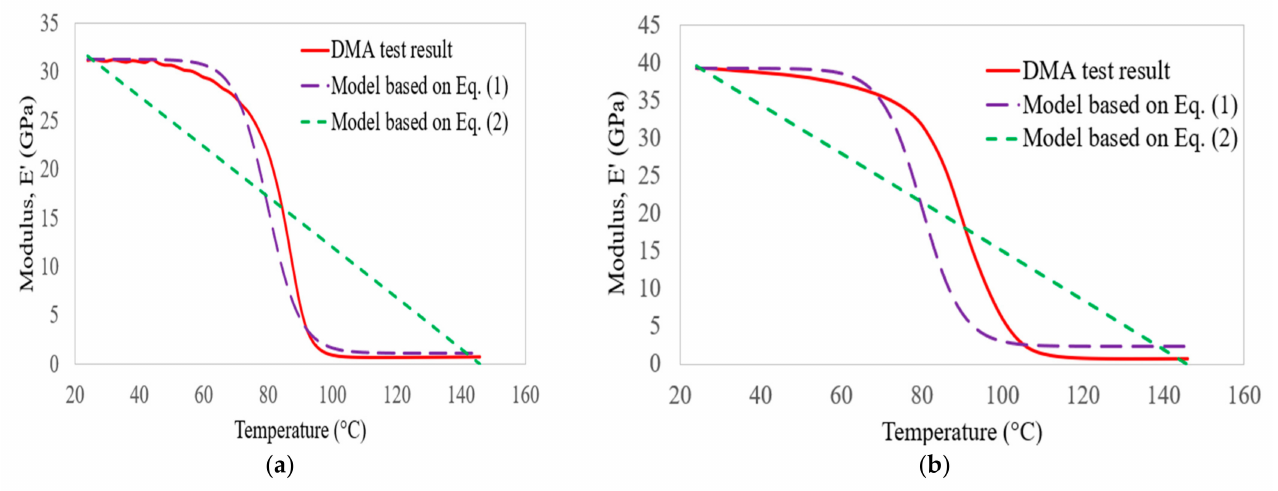
Figure 9. Comparison of carbon laminate storage modulus results with empirical models at 1 Hz ( a ) and 100 Hz ( b